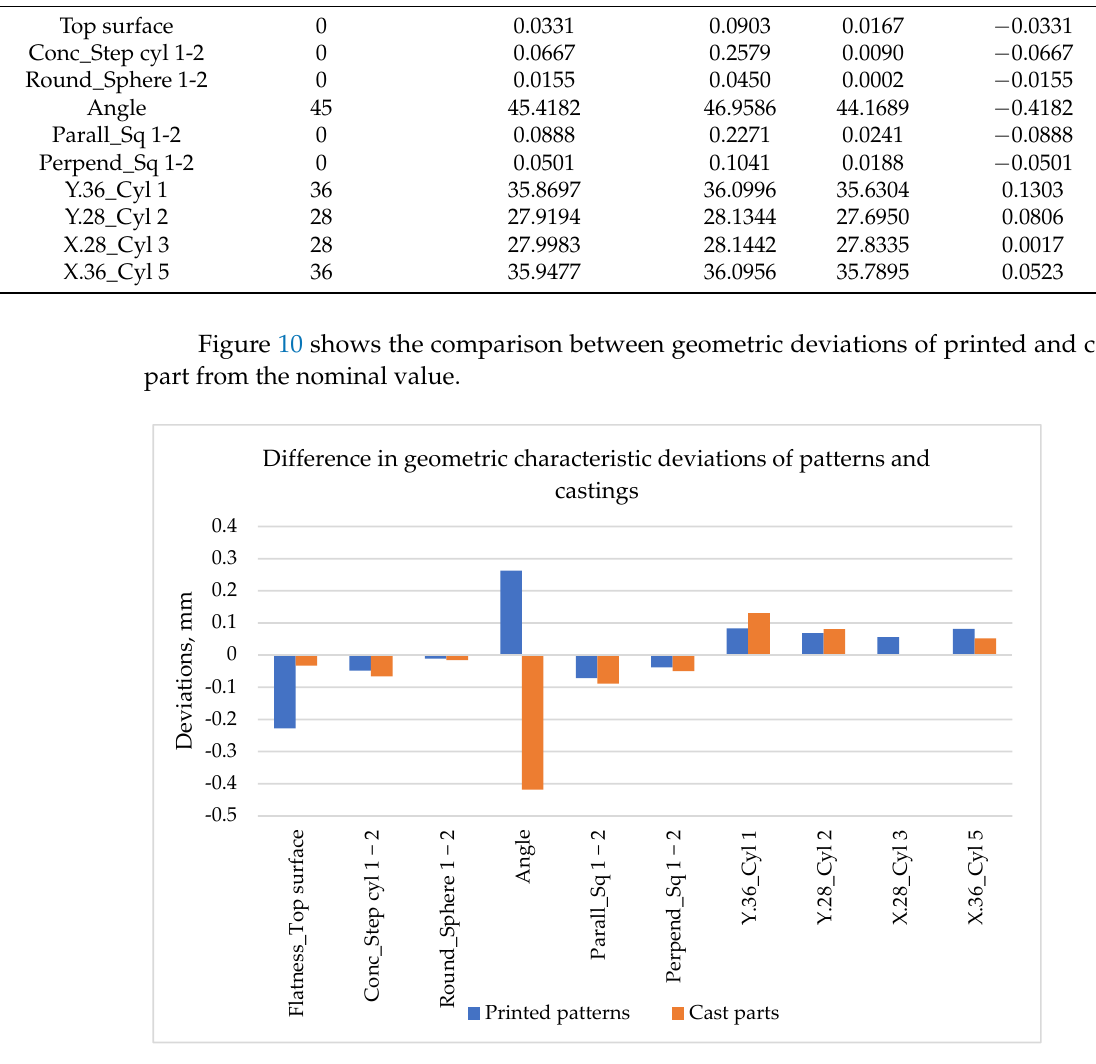
Table 20. S/N ratio ranking of parameters for geometric characteristic of cast parts.